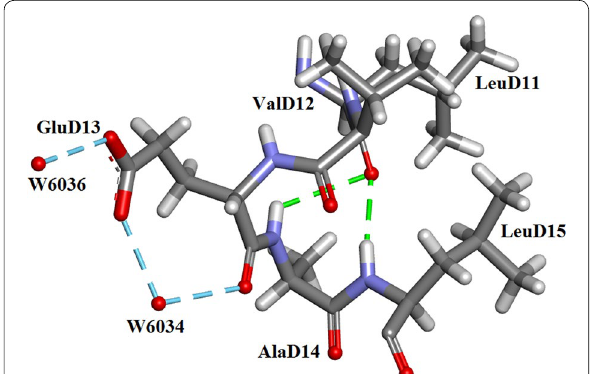
Fig. 10 Structure of the Insugen (I) sequence LeuD11–LeuD15. In which only GluD13 forms H‑bonds with solvated water molecules. In the Insugen (I) structure only 18 of 102 residues fail to link to solvated water molecules. Drawn with Accelrys Discovery Studio 3 [23] [note Intergen (II) also displays this H‑bonding in the LeuD11–LeuD15